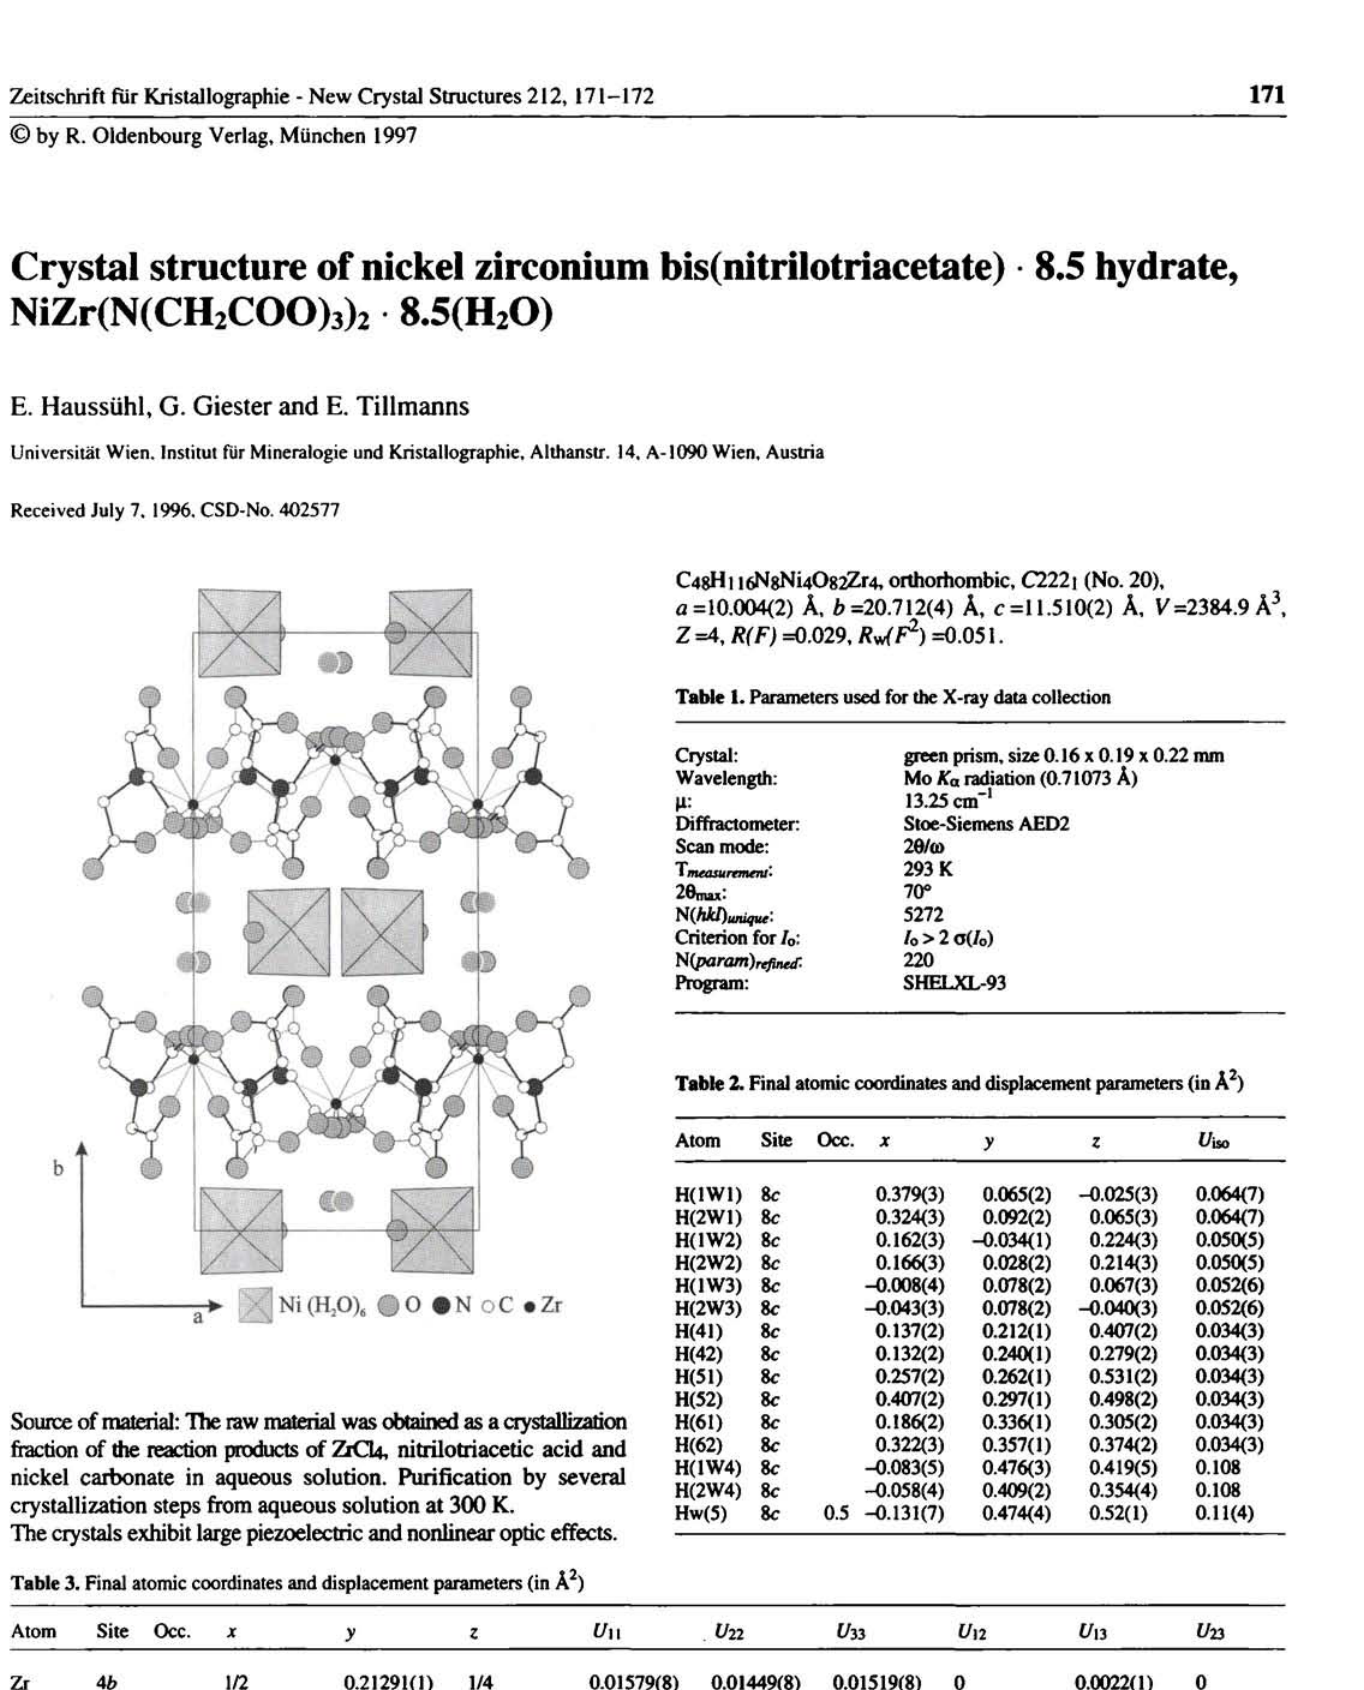
Table 3. Final atomic coordinates and displacement parameters (in Â 2 ) Atom Site